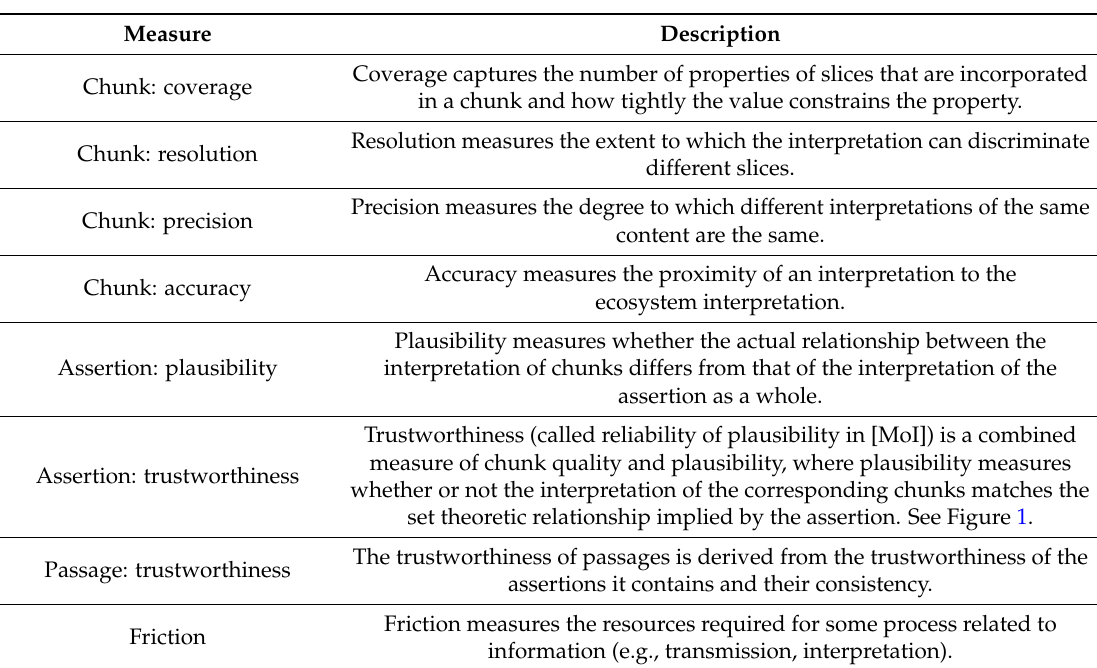
Figure 1. Trustworthiness, Plausibility and Chunk Quality. Table 1. Quality and Friction